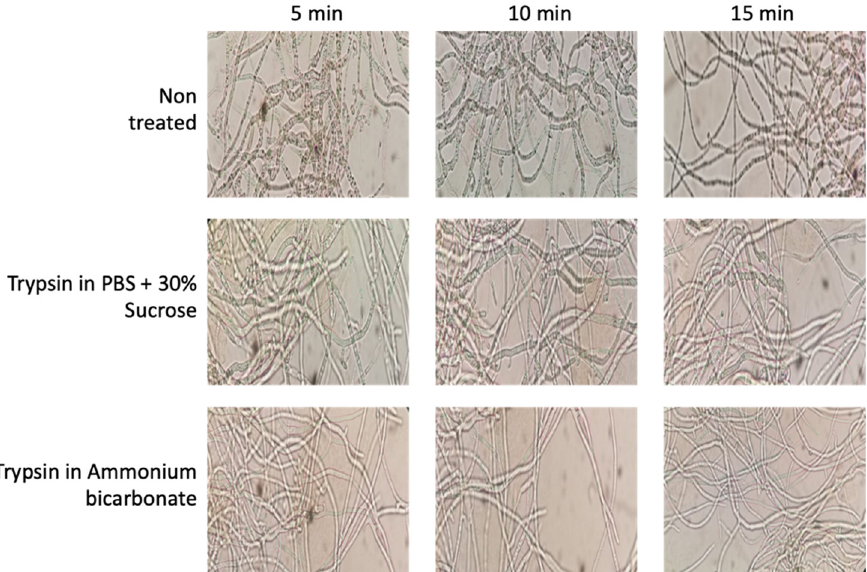
Figure 2. Effects of trypsin treatments on cell integrity using PBS plus sucrose and ammonium bicarbonate buffers during 5, 10, and 15 min, showing the maintenance of cell integrity during the protocol (Motic Microscope, Moticam 2.0 camera using 40× Objective).